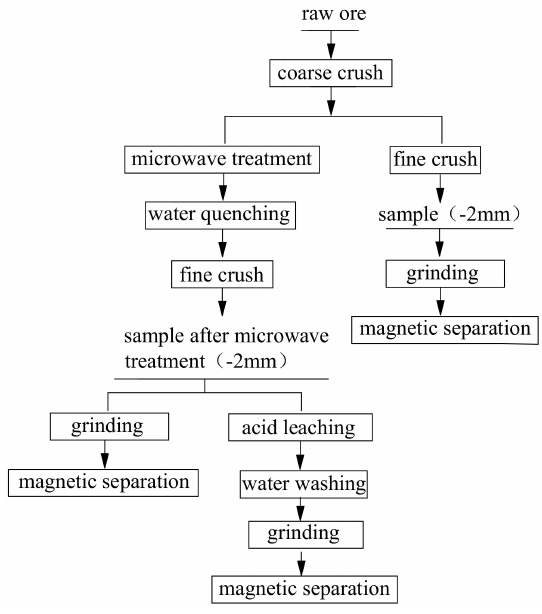
Figure 2. The basic flowchart of the